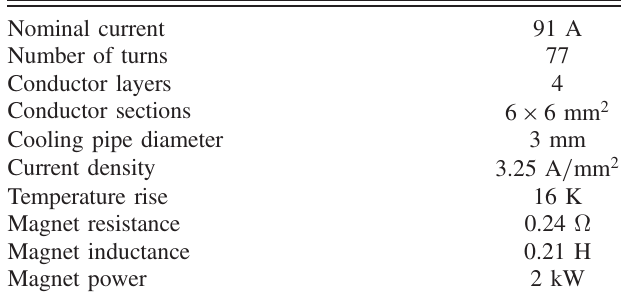
TABLE III. Coils and electrical